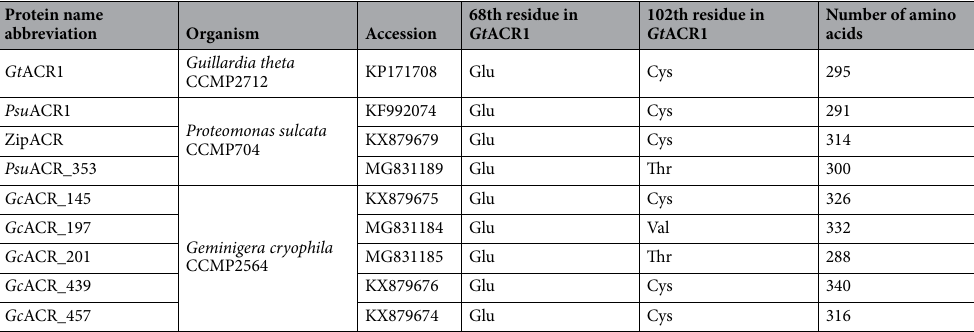
Table 1. Gene and amino acid information of ACRs used in this study. Data taken from 5,16–19